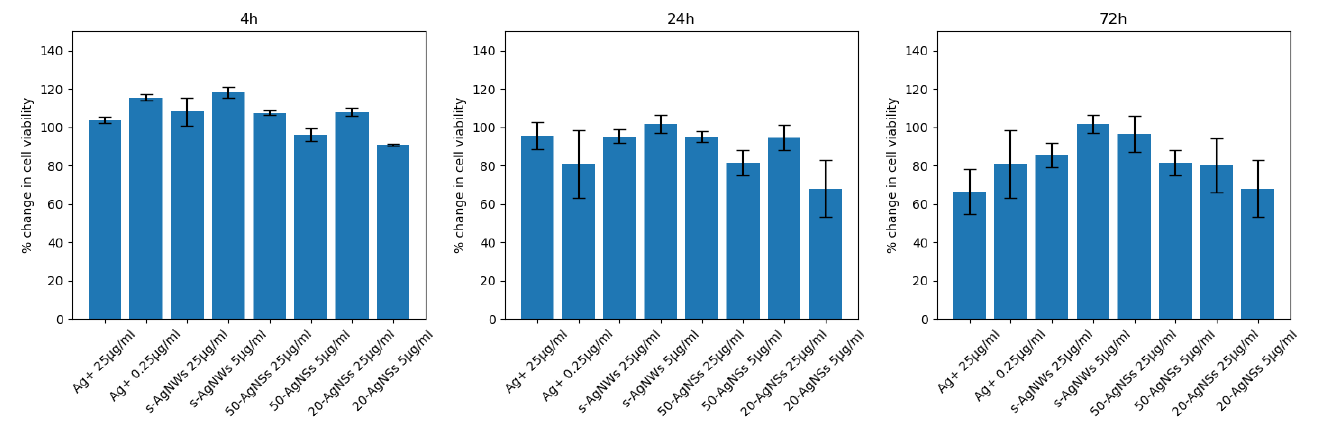
Figure 21. Concentration and time-dependent effect of AgNSs and AgNWs, and Ag + ions on ASM cell viability after 4 h, 24 h and 72 h. The bars represent mean values of 3 ASM cell donors and the whiskers indicate standard error of the mean (SEM). The data is expressed as percentage change with respect to the untreated control. This plot was formed from the dataset also reported in [32].